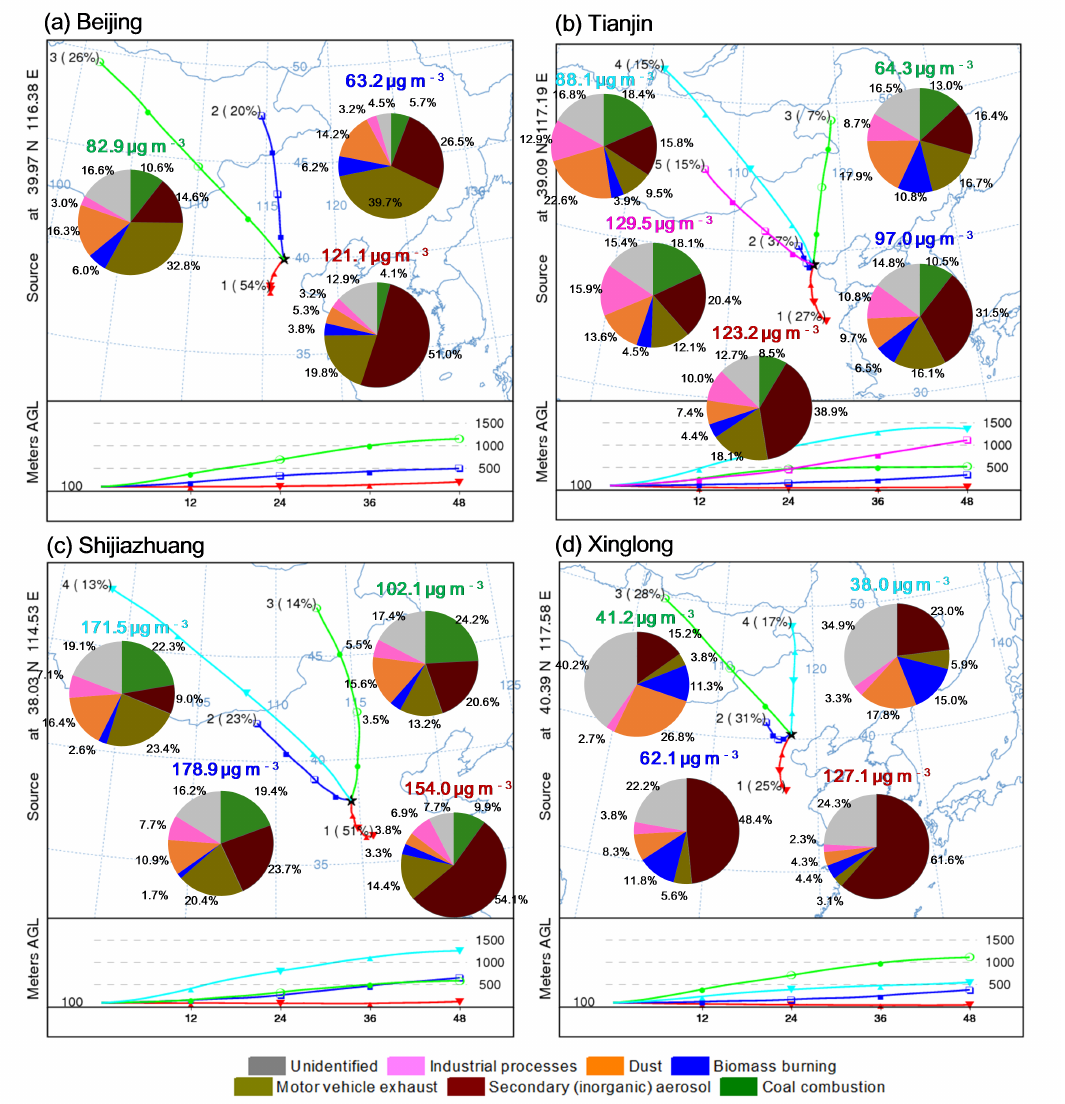
Figure 10. Source contributions resolved from the PMF at each 48h backward-trajectory cluster during the entire study period in Beijing (a) , Tianjin (b) , Shijiazhuang (c) , and Xinglong (d)